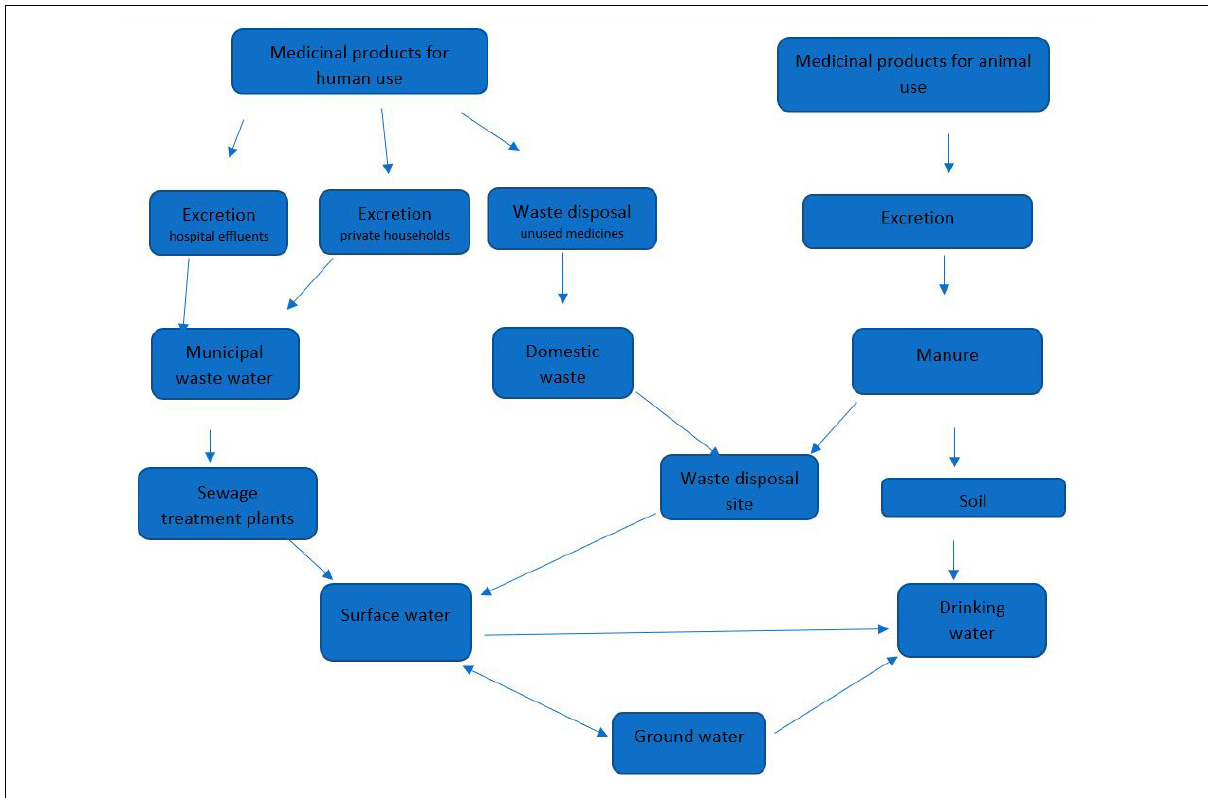
Figure 1: Sources and pathways by which pharmaceuticals may enter water